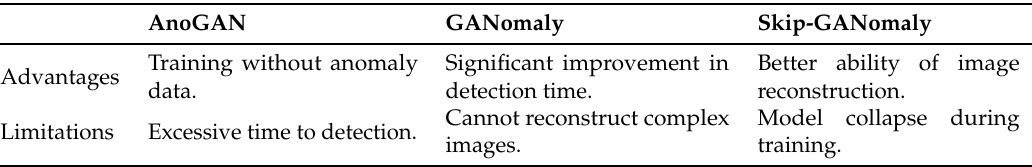
Significant improvement in detection time. Cannot reconstruct complex images.